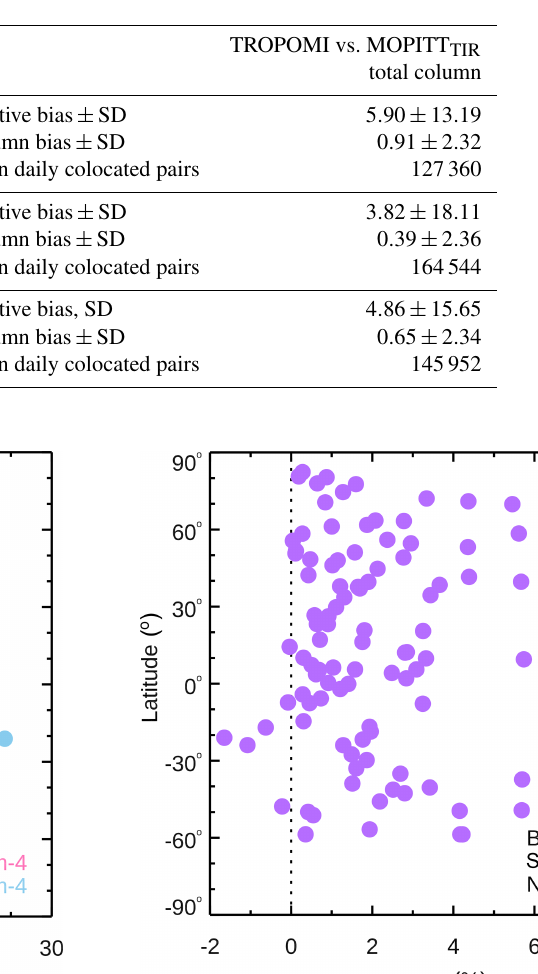
Table 5. Colocated, null-space-adjusted TROPOMI vs. MOPITT TIR CO retrievals over bodies of water: statistics analysis performed for the period between 7 November 2017 and 10 March 2019. Relative bias and SD are in percent. Column bias and SD are in units of 10 17 moleccm − 2 .